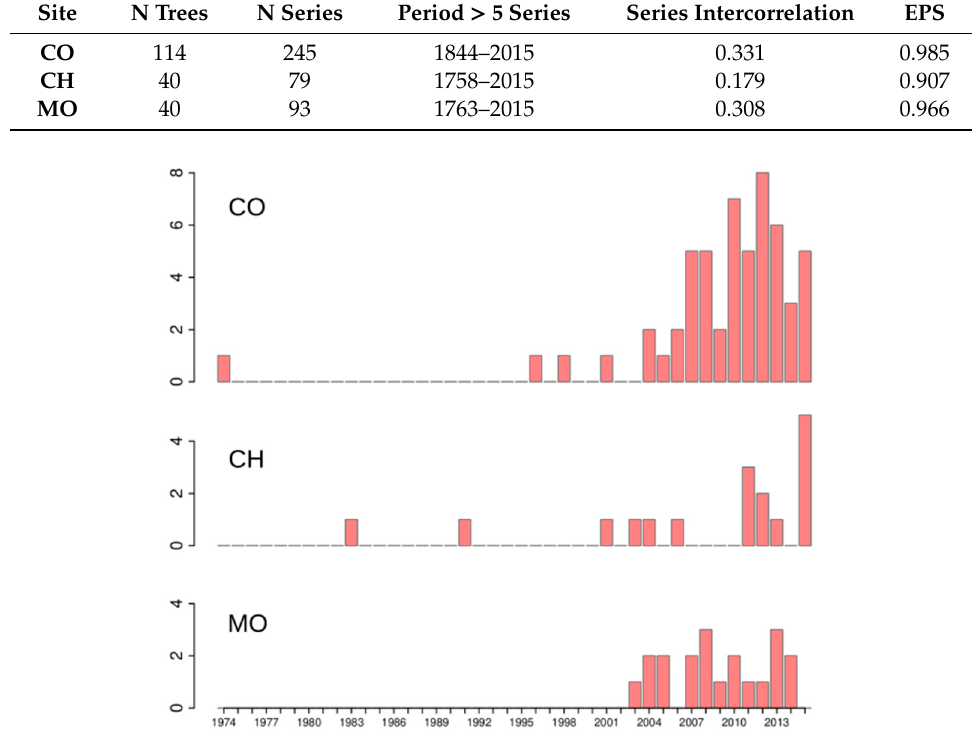
Figure 2. Number of tree deaths per year at the three sample sites.